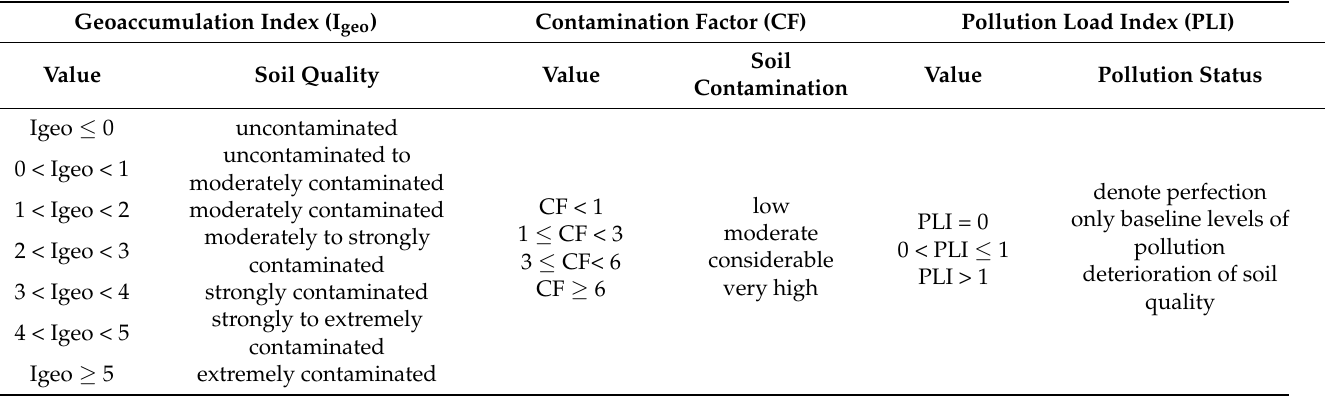
Table 2. Interpretation of the values and classes of indices